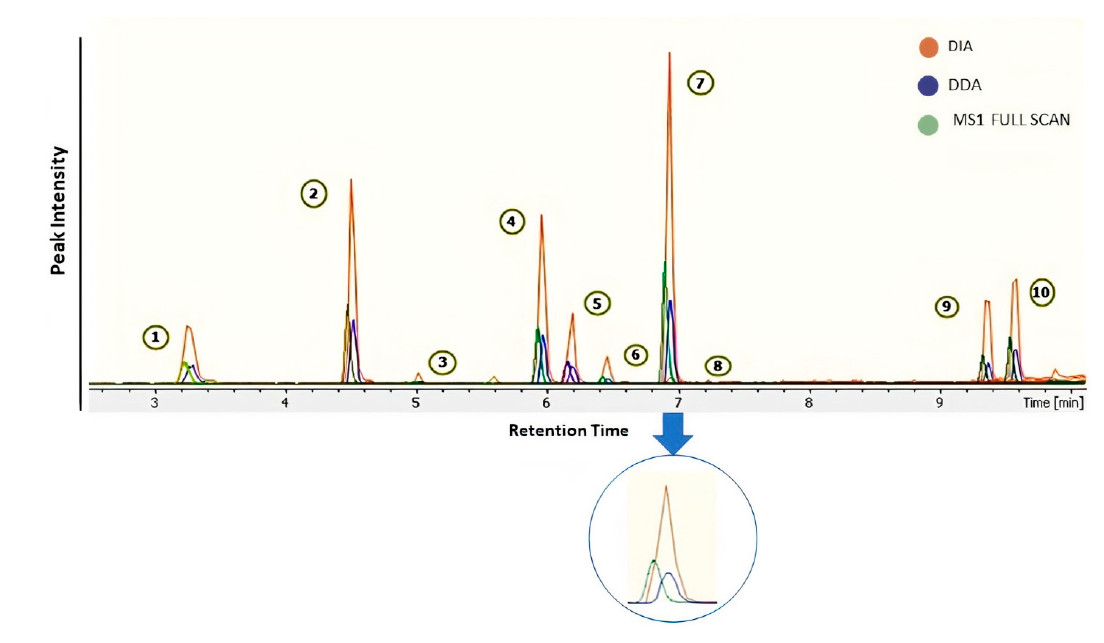
Figure 3. Extracted ion chromatograms of 10 drug standards ( 1 . Ranitidine; 2 . Oxytetracycline; 3 . Ranolazine; 4 . Atropine; 5 . Diphenhydramine; 6 . Haloperidol; 7 . Dipyridamole; 8 . Duloxetine; 9 . Finasteride; 10 . Phenylbutazone) in the QC sample and improved sensitivity of drug standards in various modes.